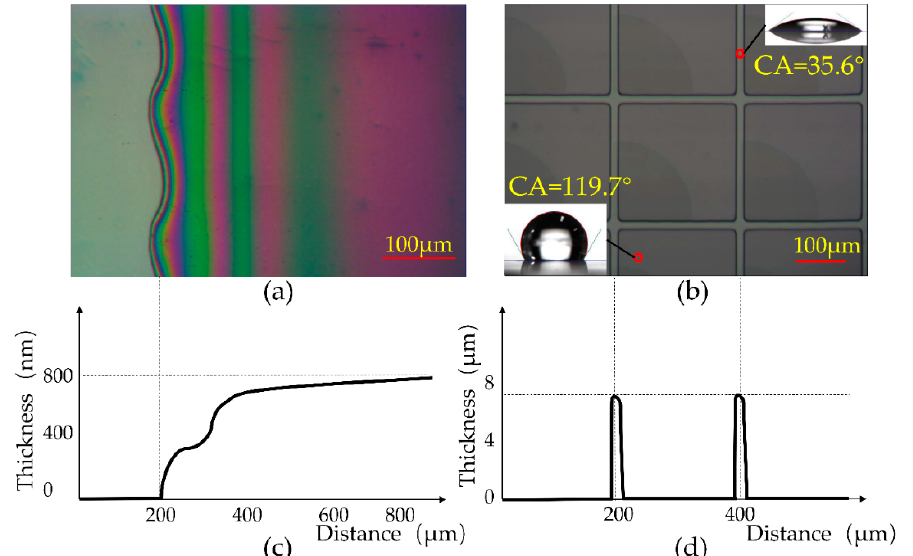
Figure 5. Fabrication results characterization after insulator and lithography steps. ( a ) Optical